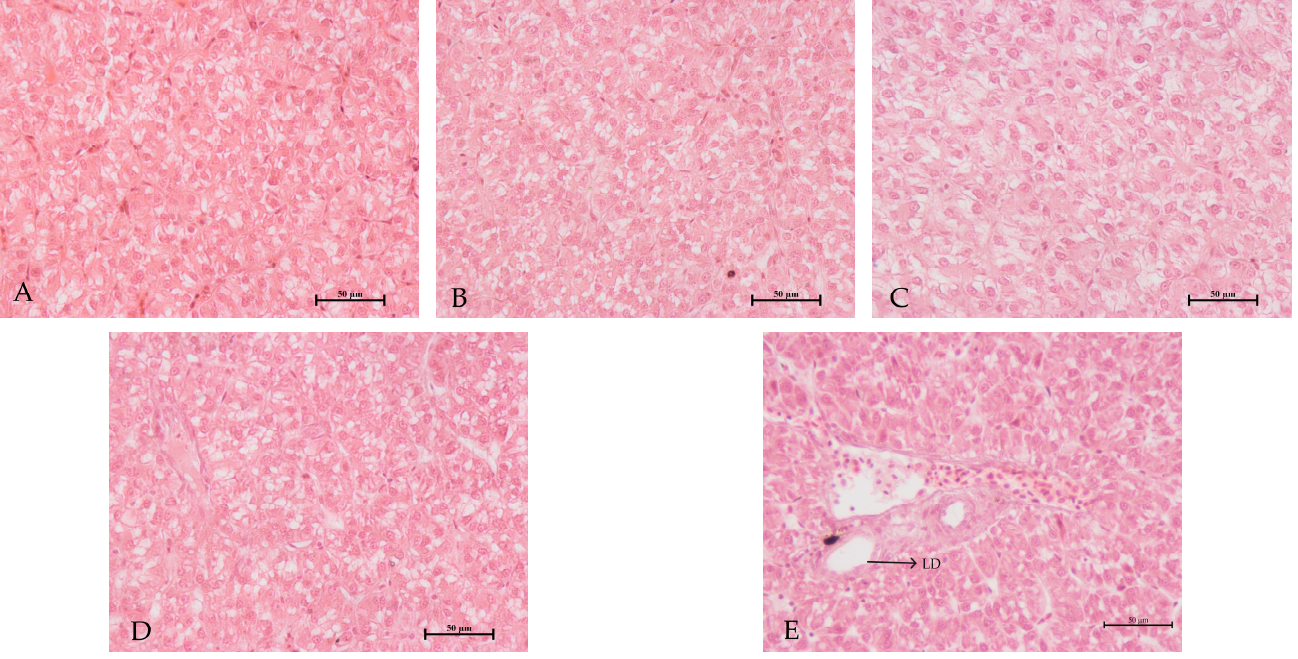
Figure 2. Effect of replacing fishmeal with CPC and CAP mixture on hepatopancreas morphology of rainbow trout (40 × ). ( A ): CON; ( B ): FM-15; ( C ): FM-10; ( D ): FM-5; ( E ): FM-0; LD: lipid droplet. Scale bar = 50 µ